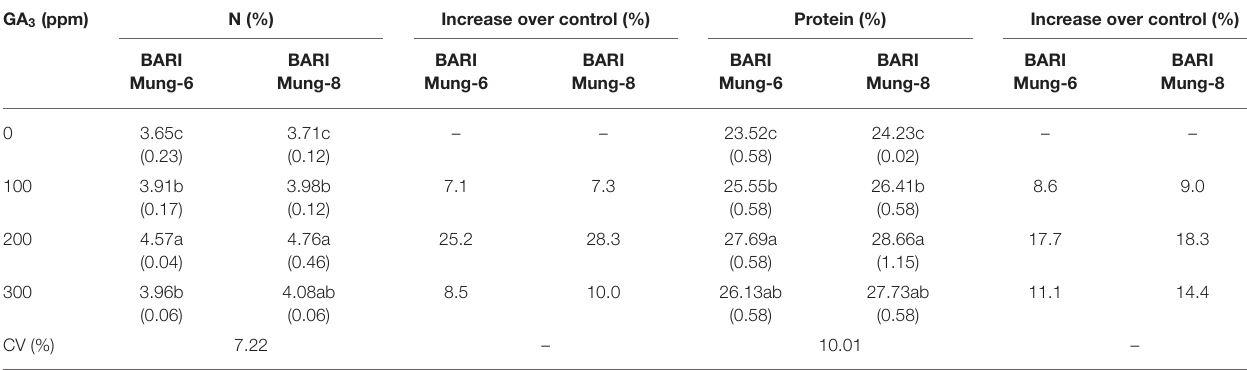
TABLE 9 | Effect of different concentration of GA 3 on N and protein content (%) of V. radiata varieties. GA 3 (ppm)